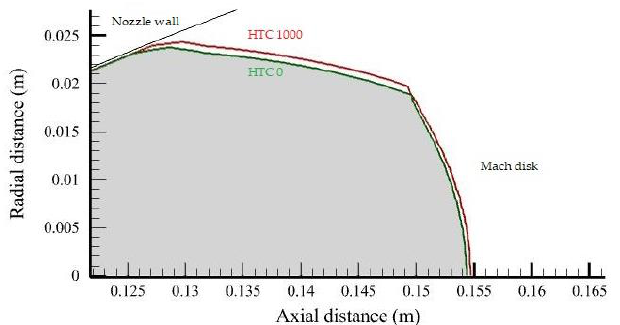
for the considered NPRs (Figure 14). Therefore, it could be concluded that for higher inlet